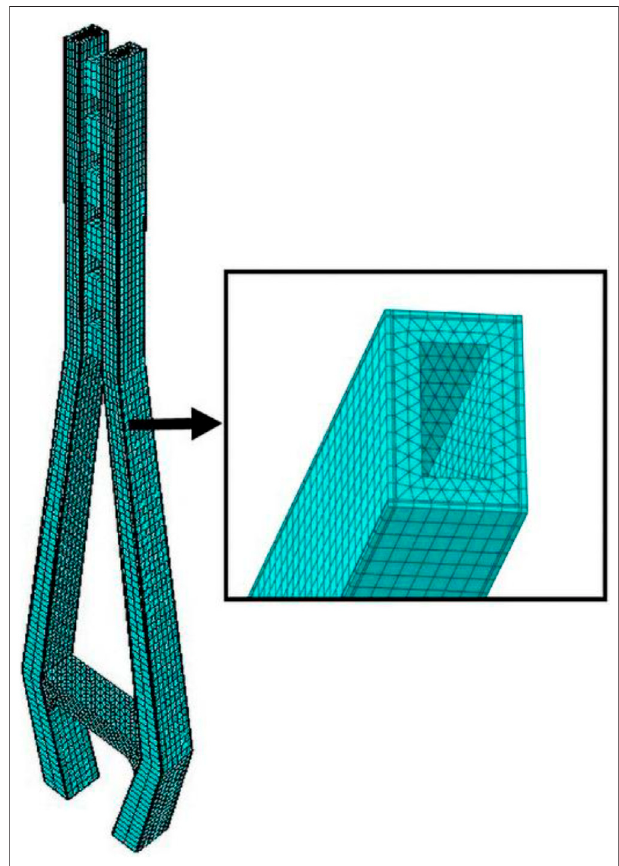
FIGURE 4 | The diagram of the tower grid